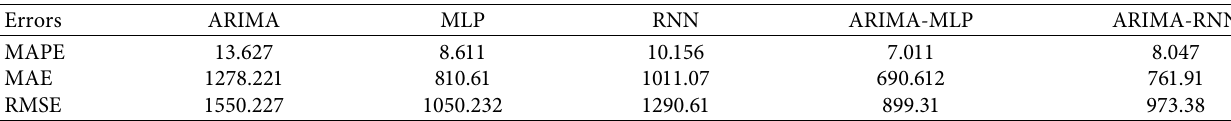
Figure 2: Stock prices of Pakistan. Table 2: Forecasting performance of different models.